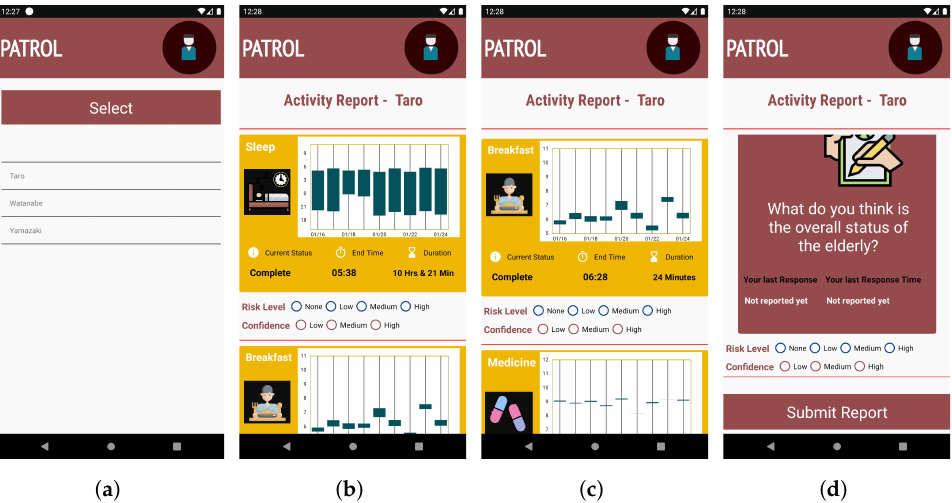
Figure 3. Snippet of the smartphone application for: ( a ) choosing Targets, ( b ) sleep card, ( c ) breakfast card, and ( d ) submitting